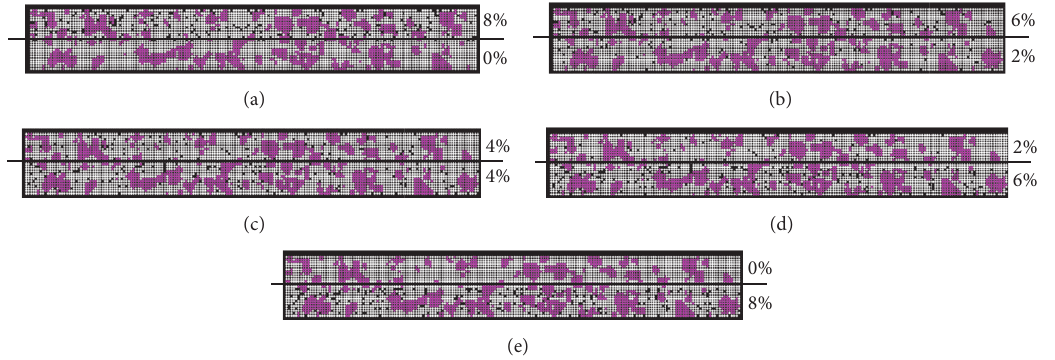
Figure 9: Vertical distribution of air voids: (a) V8/0; (b) V6/2; (c) V4/4; (d) V2/6; (e) V0/8.